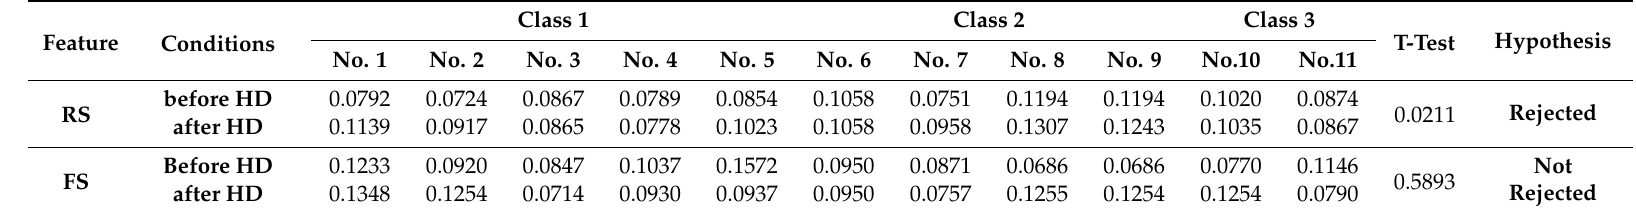
Table 3. RS and FS features of HD